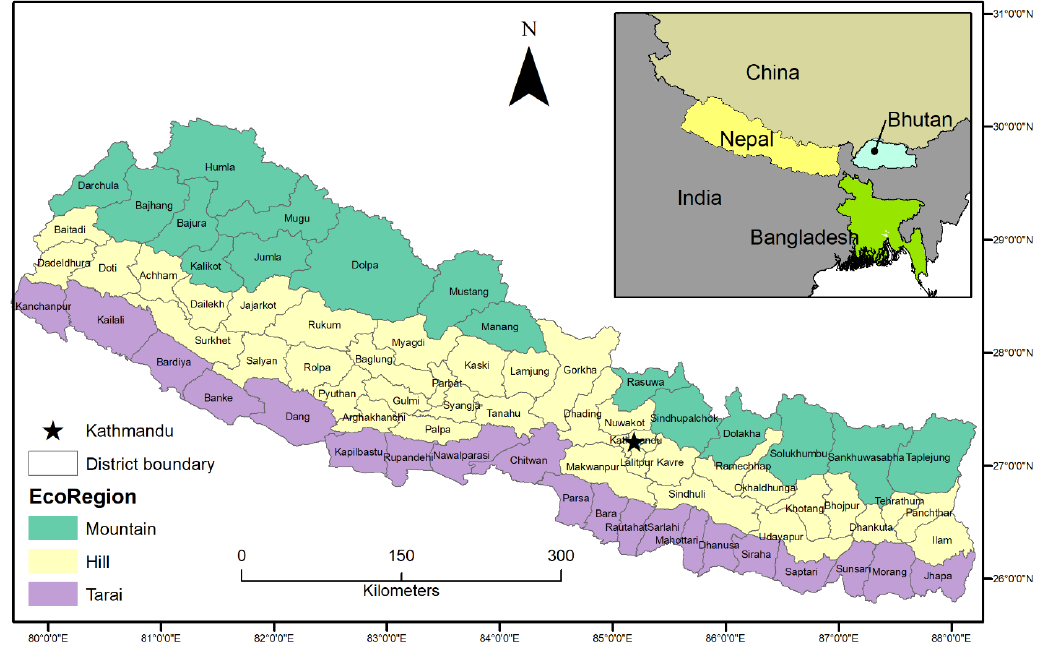
Figure 1. Administrative map of Nepal.